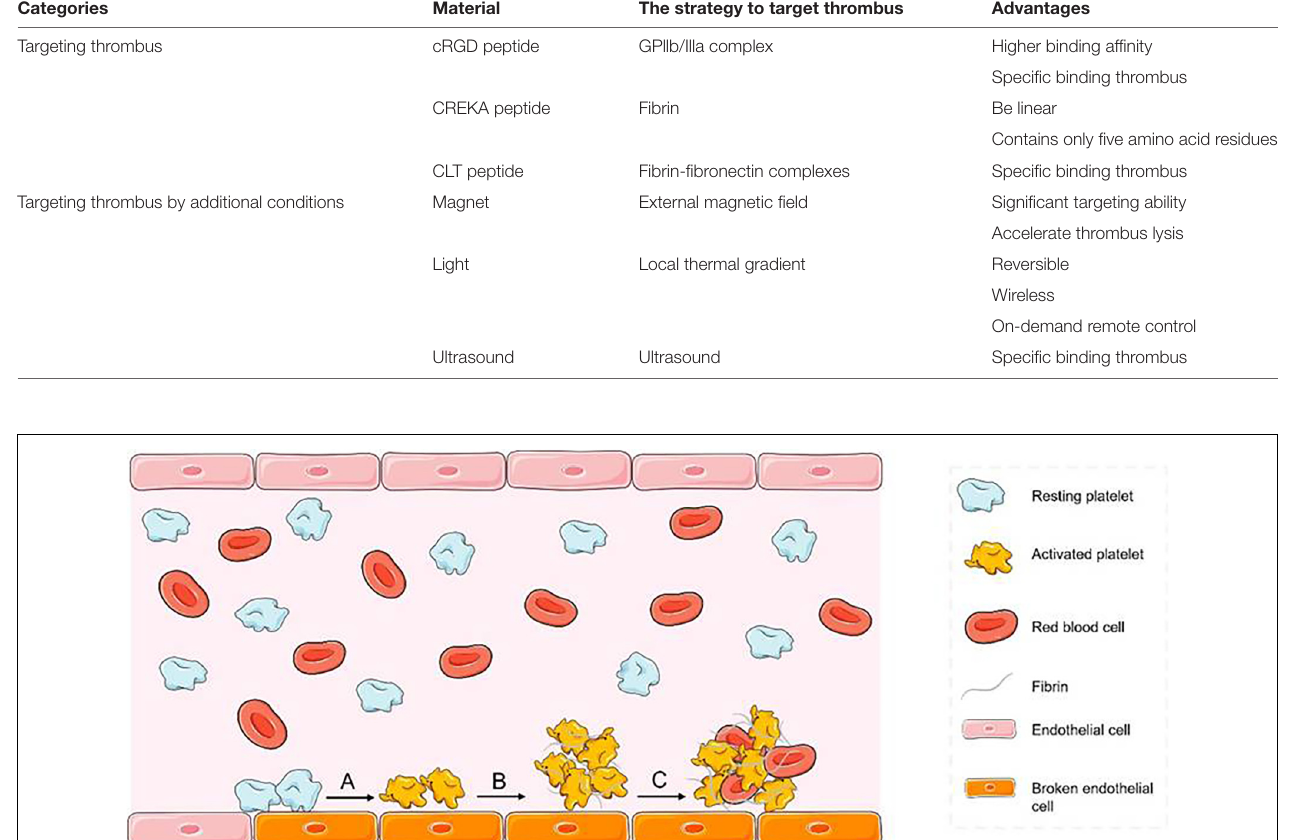
fusion to microfibrin ( µ Pn); CLT was able to recognize fibrin- fibronectin complexes in thrombi, enabling efficient targeting of thrombus